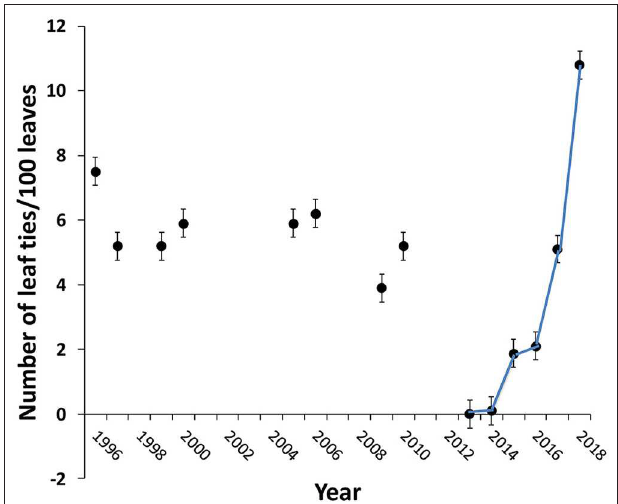
FIGURE 3 | Impact of 2012 drought on the number of leaf ties on Quercus alba at Cuivre River State Park, near Troy, MO. Data for years 2013–2018, this study. Error bars are 95% confidence intervals for each point. Data sources for years prior to 2012: 1996 (Lill, 2004), 1997 (Marquis and Lill,